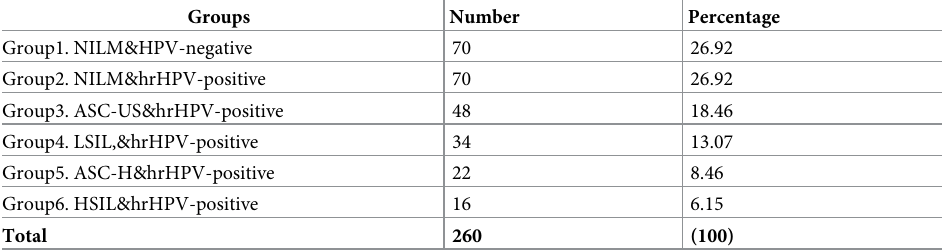
Table 1. Study population groups characterized by cytology and HPV